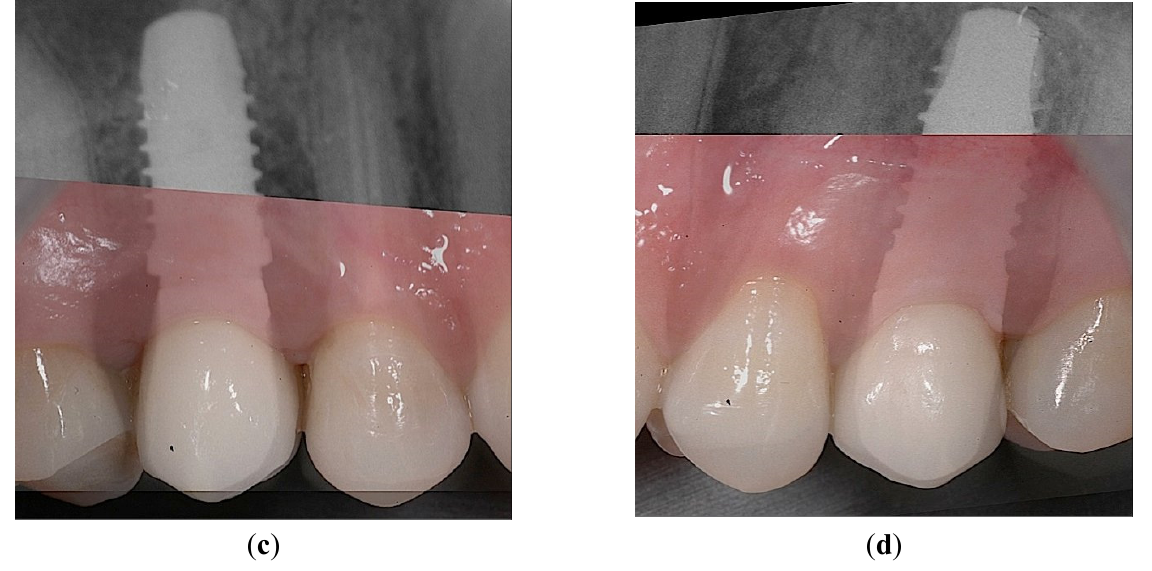
Figure 7. Intraoral views at one-year follow-up. ( a ) The optimal gingival margin was formed beneath the permanent crowns, both in the case of PFS, ( b ) as well as the StE implants. Superimposed clinical and X-ray pictures: ( c ) Position 15, PFS; ( d ) Position 25,